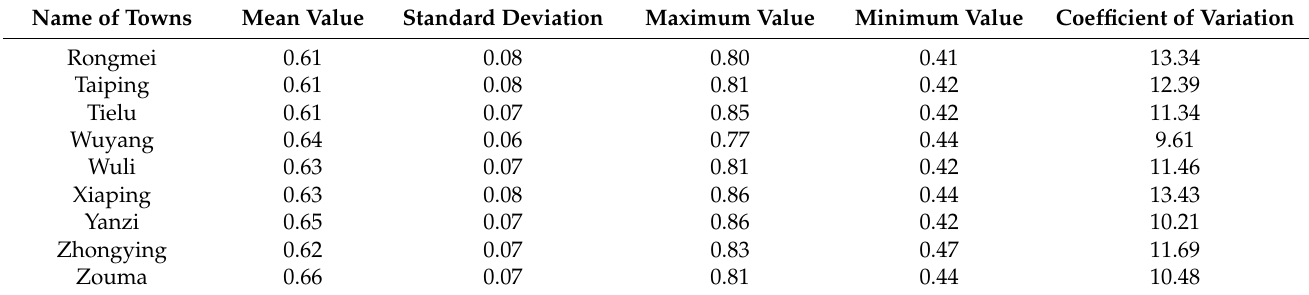
Figure 3. Spatial distribution of forest land quality index (FLQI) in Hefeng. Table 2. Statistical characteristics of forest land quality index (FLQI) of